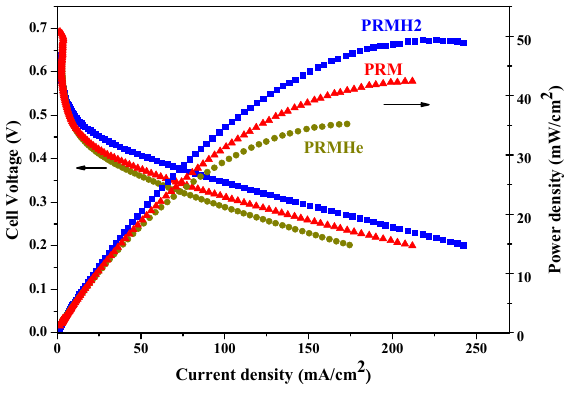
Figure 8. Cell voltage versus current densities and power densities of a DMFC single cell. Adapted from Tsiouvaras et al.